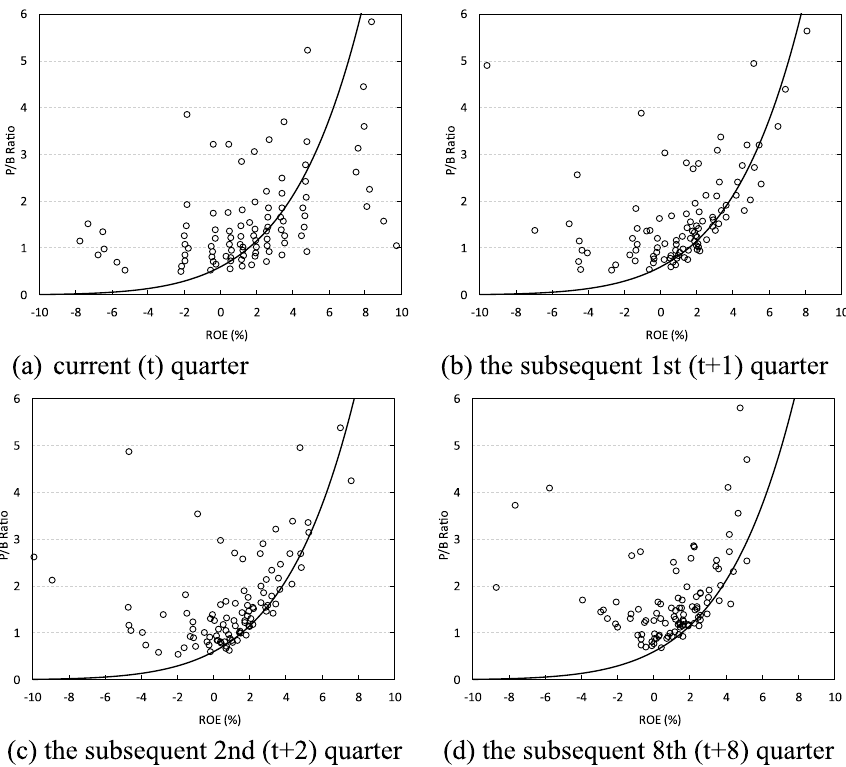
Fig. 12 ROE (X axis) and P/B (Y axis) in the current quarter and the subsequent 1st, 2nd, and 8th quarter after the portfolios are formed: High risk